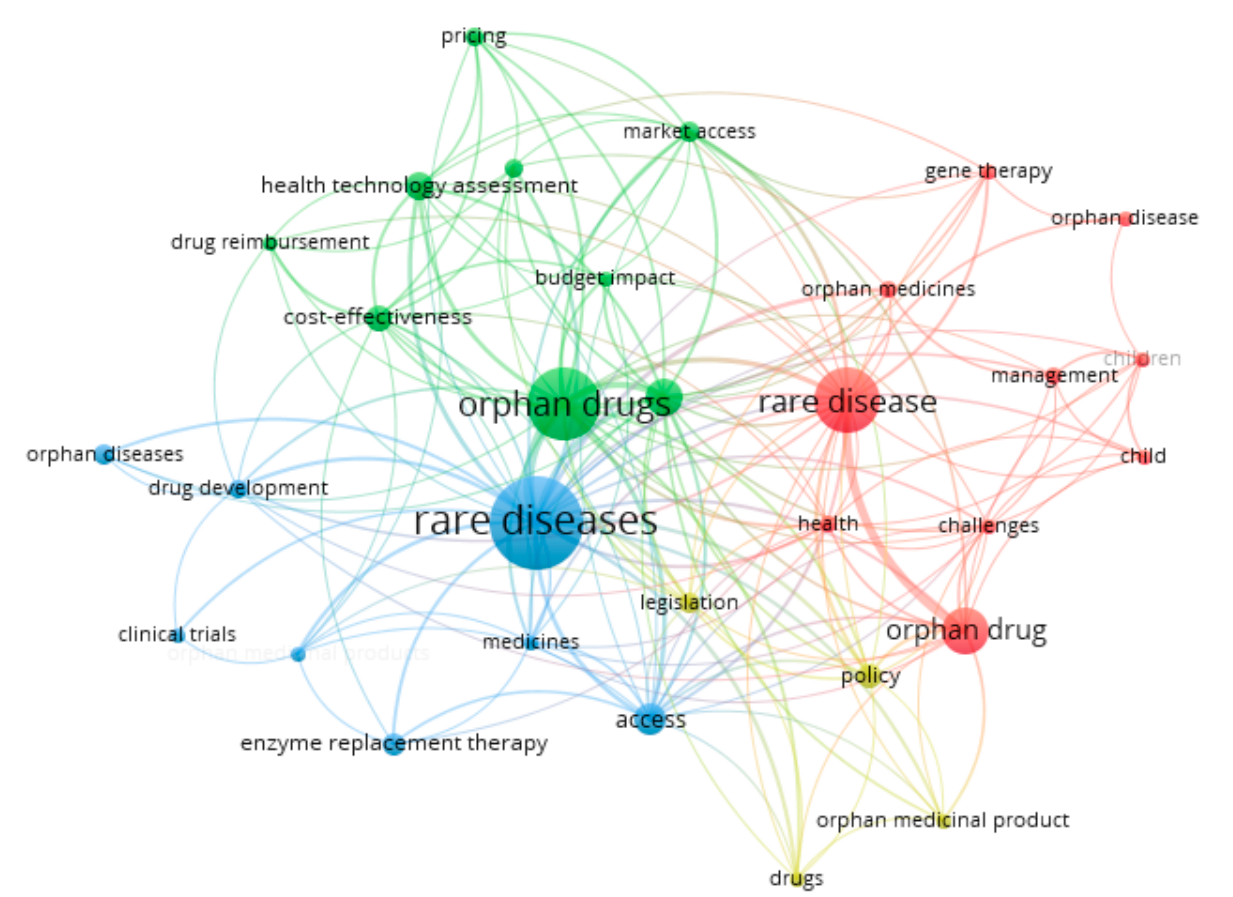
Figure 4. Mapping latent variables from keywords of the publications on issues connected with rare diseases. Note: Technical publication on mapping and clustering using VOSviewer [36,37]. Limitations: the authors did not take into account many valuable publications in the study, instead taking into account the need to narrow the thematic scope of the described issues. Source: own elaboration based on 343 references [44–386].